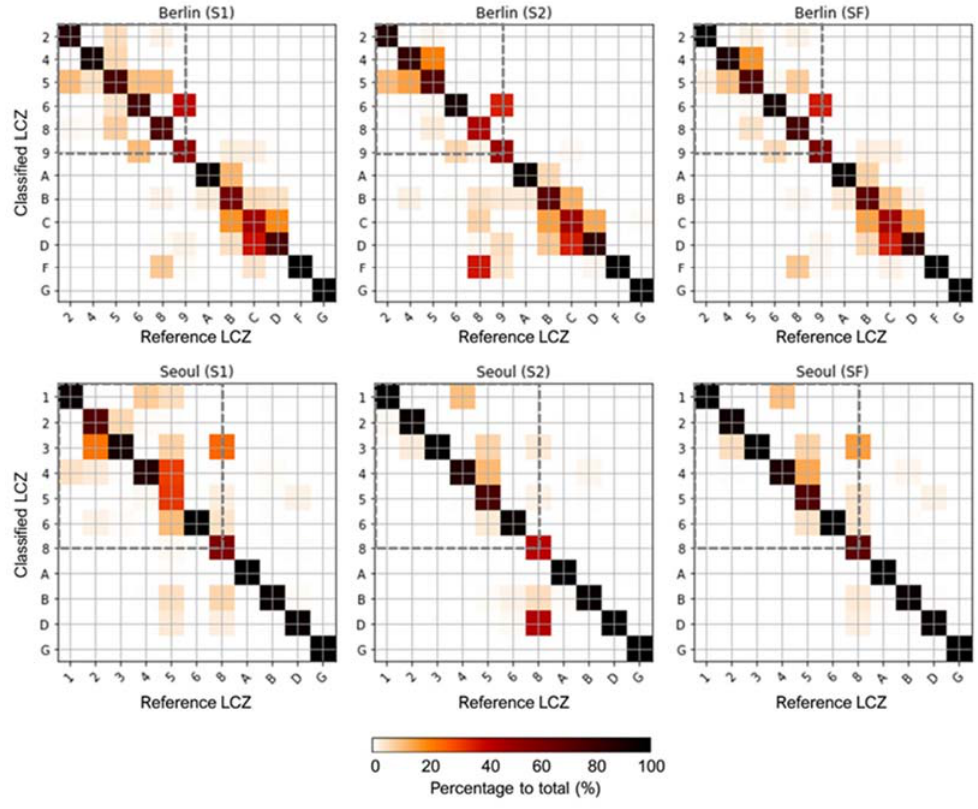
Figure 6. Confusion matrices of three schemes for Berlin and Seoul. The most accurate model results are presented by percentages to the total numbers of ground reference data. The dashed box indicates the urban-type LCZ